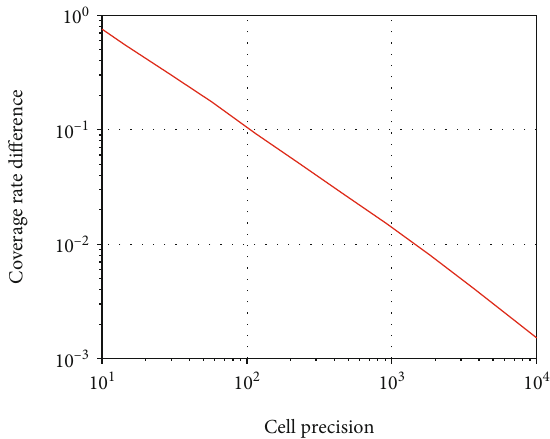
Figure 7: The di ff erences between the upper and lower bound of coverage rate for